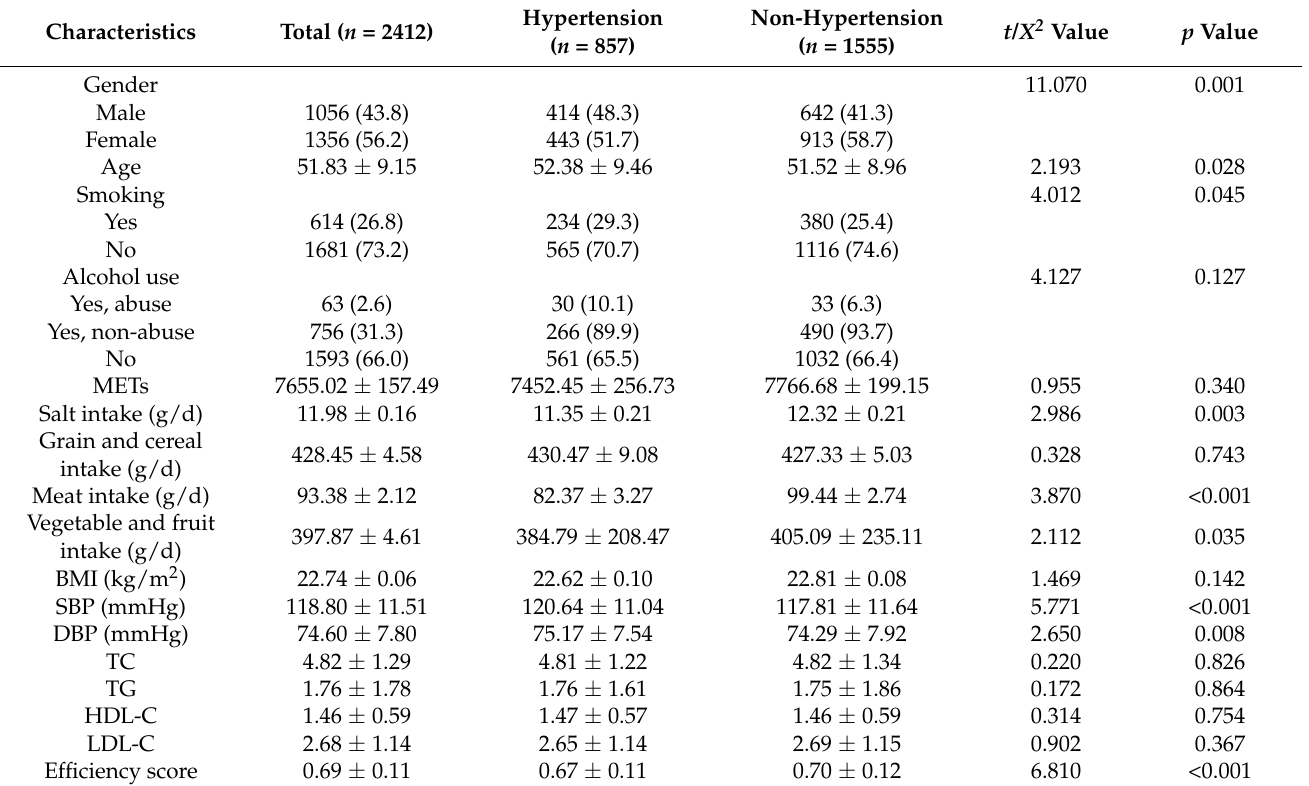
Table 1. Baseline characteristics of the study